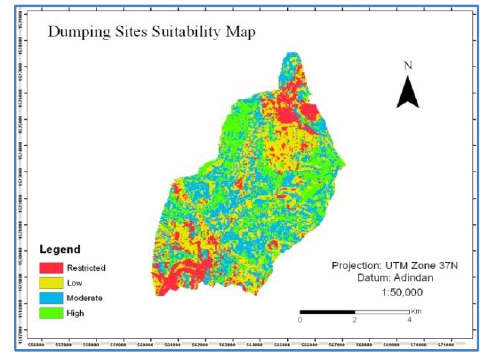
Figure 2: Dumping Sites Suitability Map of Wukro town